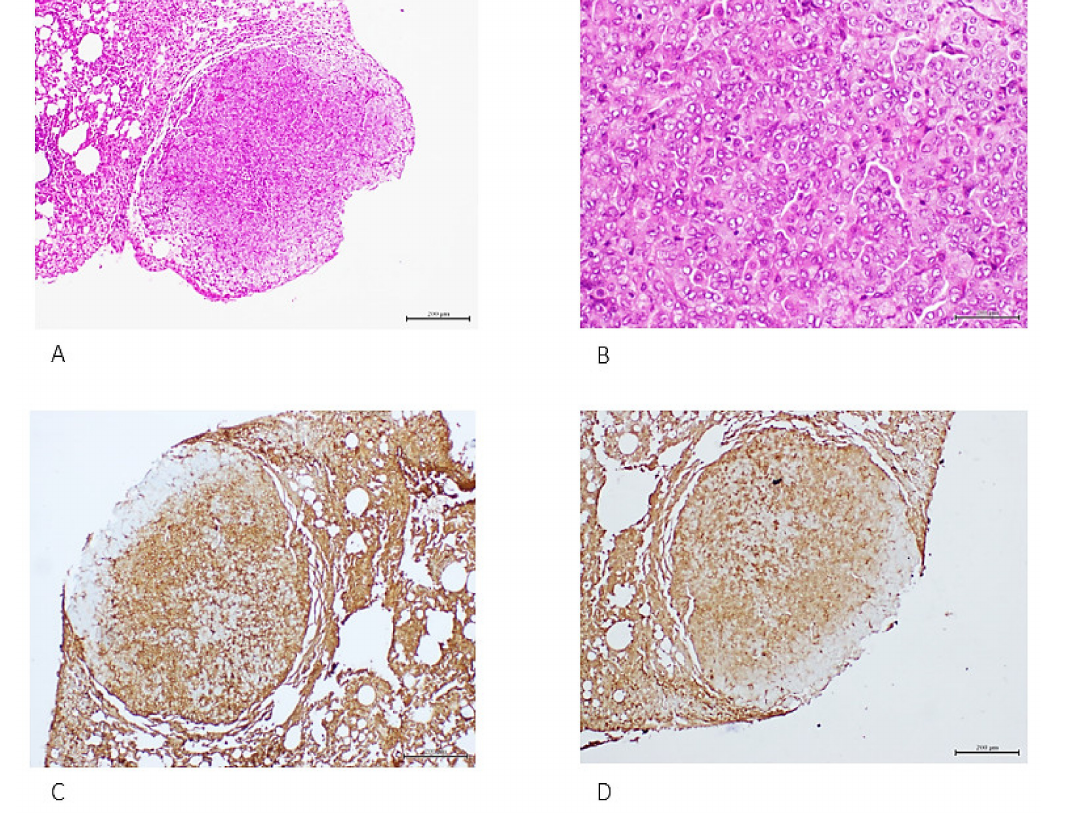
Figure 3. Lung solid tumor nodule detected at the early autopsy time point. ( A ). Well-consolidated tumor nodule with parietal, sub-pleural growth. The histological analysis identified poorly differ- entiated epithelial cells with vacuolated cytoplasm, vesiculous nuclei and prominent nucleoli, ( B ). This tumor was concluded as a poorly differentiated adenocarcinoma reactive to CEA and TTF-1, ( C , D ) respectively. H/E. Magnifications: × 4 and × 40. Scale bar: 200 µ